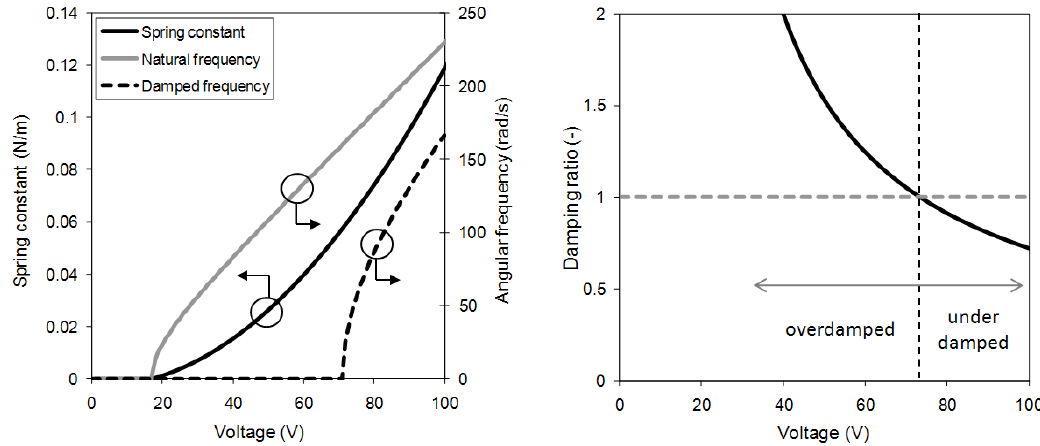
Figure 5. Force profile as a function of the droplet position for an actuation voltage of 45 V: actual calculated profile (solid black line), difference between the actuation force and the static contact line friction (solid grey line) and the linearized force profile (dashed